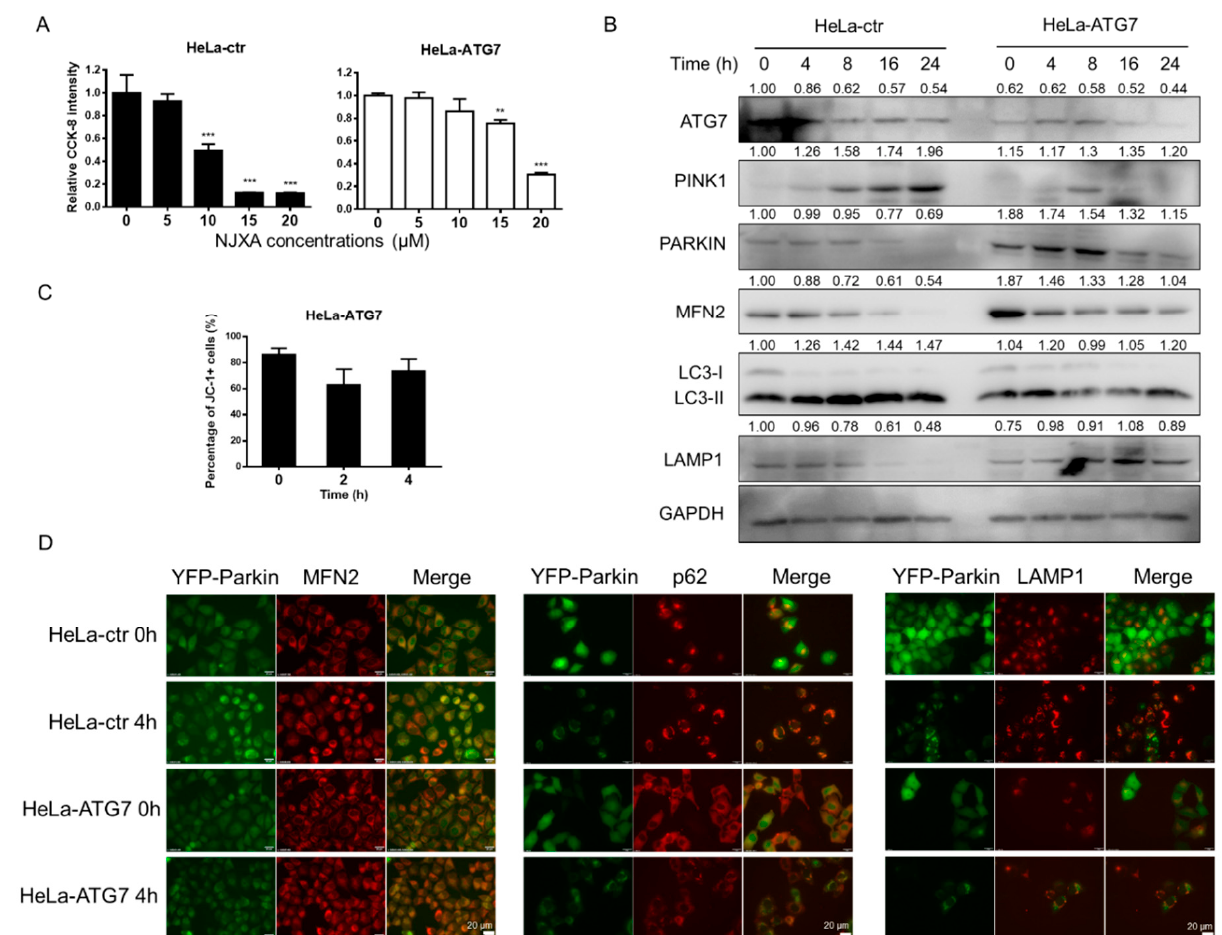
Figure 5. Effect of NJXA on HeLa cells is partially reversed by mitophagy inhibition. ( A ) HeLa ‐ ctr and HeLa ‐ ATG7 cells were treated with NJXA at the indicated concentrations (0–20 μ M) for 72 h and evaluated by CCK ‐ 8 assay. Data is shown as mean ± SD of three independent experiments, ** p < 0.01, and *** p < 0.001. ( B ) HeLa ‐ ctr and HeLa ‐ ATG7 cells were treated with NJXA (20 μ M) for 0–24 h and analyzed by immunoblotting for ATG7, PINK1, PARKIN, MFN2, LC3, and LAMP1. GAPDH served as the loading control. The values above the bands indicate the relative 669 band intensities. Data are presented as the means ± SEM of three independent experiments. ( C ) HeLa ‐ ATG7 cells treated with NJXA (20 μ M) for 0, 2, and 4 h were collected for mitochondrial membrane potential analysis. ( D ) YFP ‐ Parkin HeLa cells transfected with ATG7 or control plasmid cells were treated with NJXA (20 μ M) for 4 h, fixed, and stained with MFN2, p62, and LAMP1 antibodies. The images were acquired using a fluorescence microscope. Scale bar = 20 μ M.